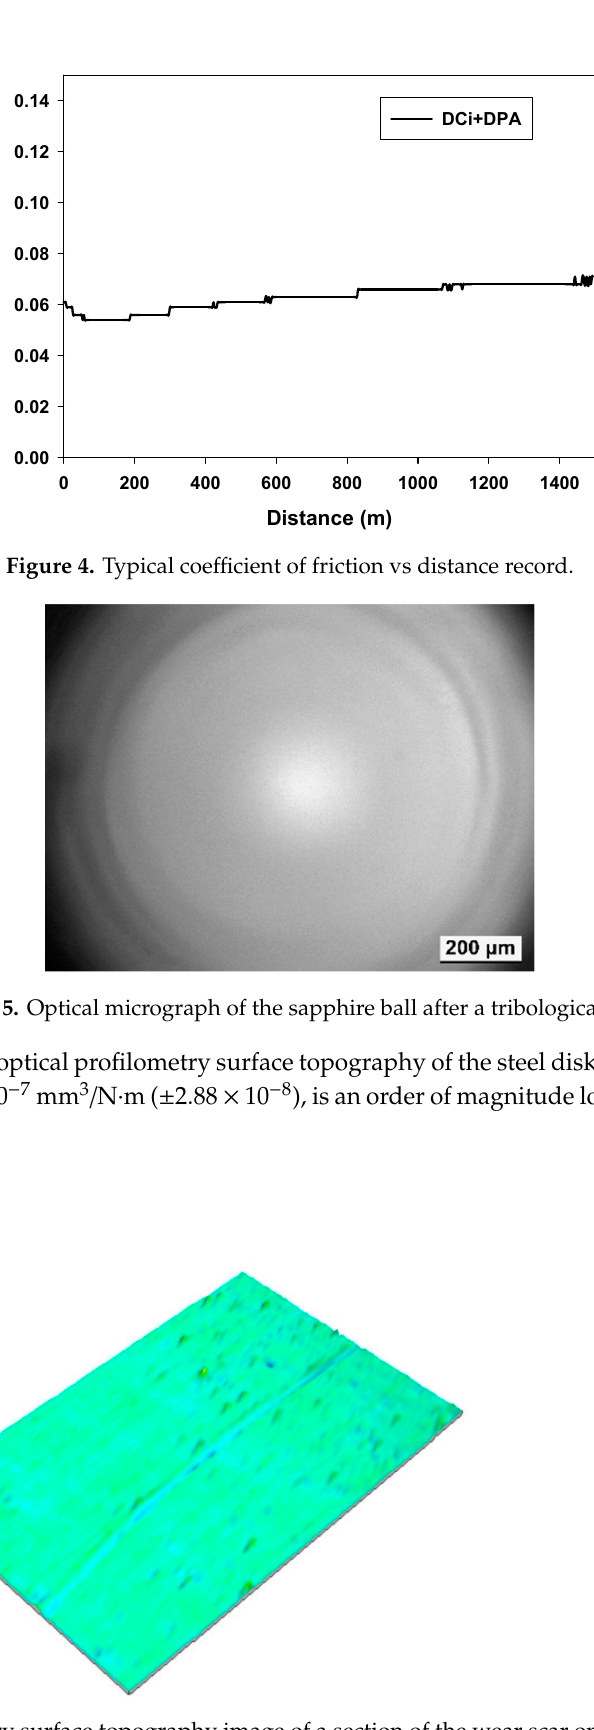
Figure 6. Profilometry surface topography image of a section of the wear scar on the AISI 316L disk after a tribological after a tribological test.